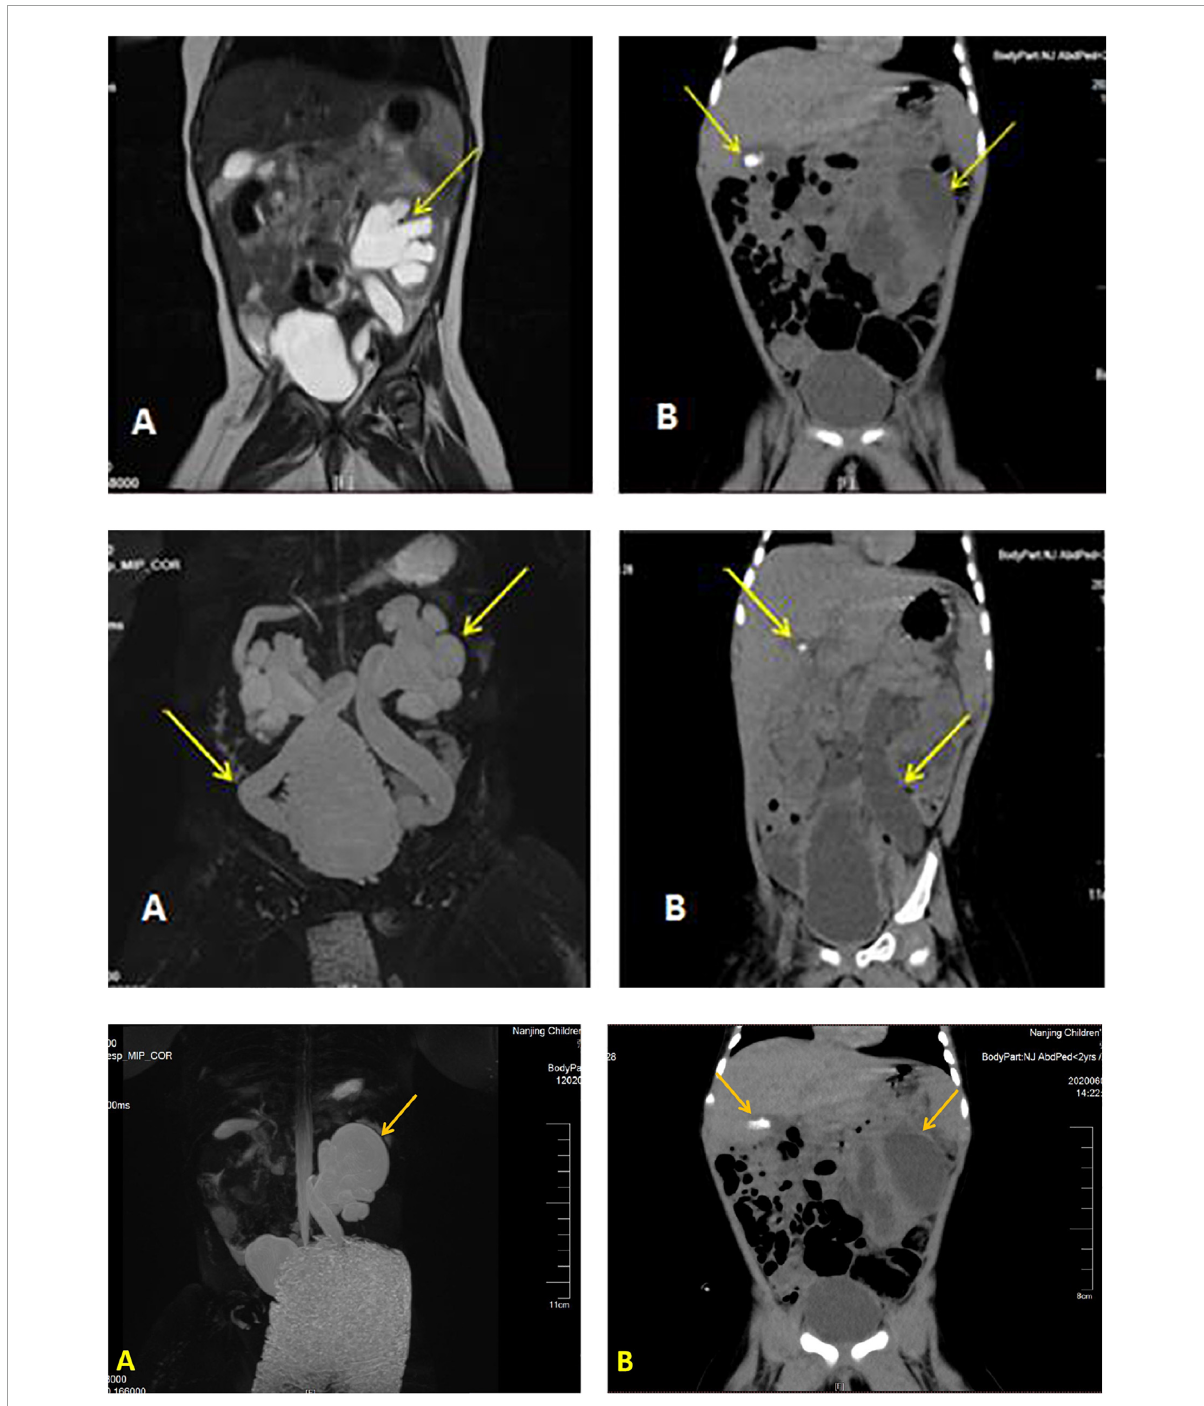
FIGURE1 Imaging results displaying a dilated left ureter and renal pelvis and gallstone in the gallbladder. Image of the urinary MR of case 1 (A) , Full abdominal CT of case 1 (B) .